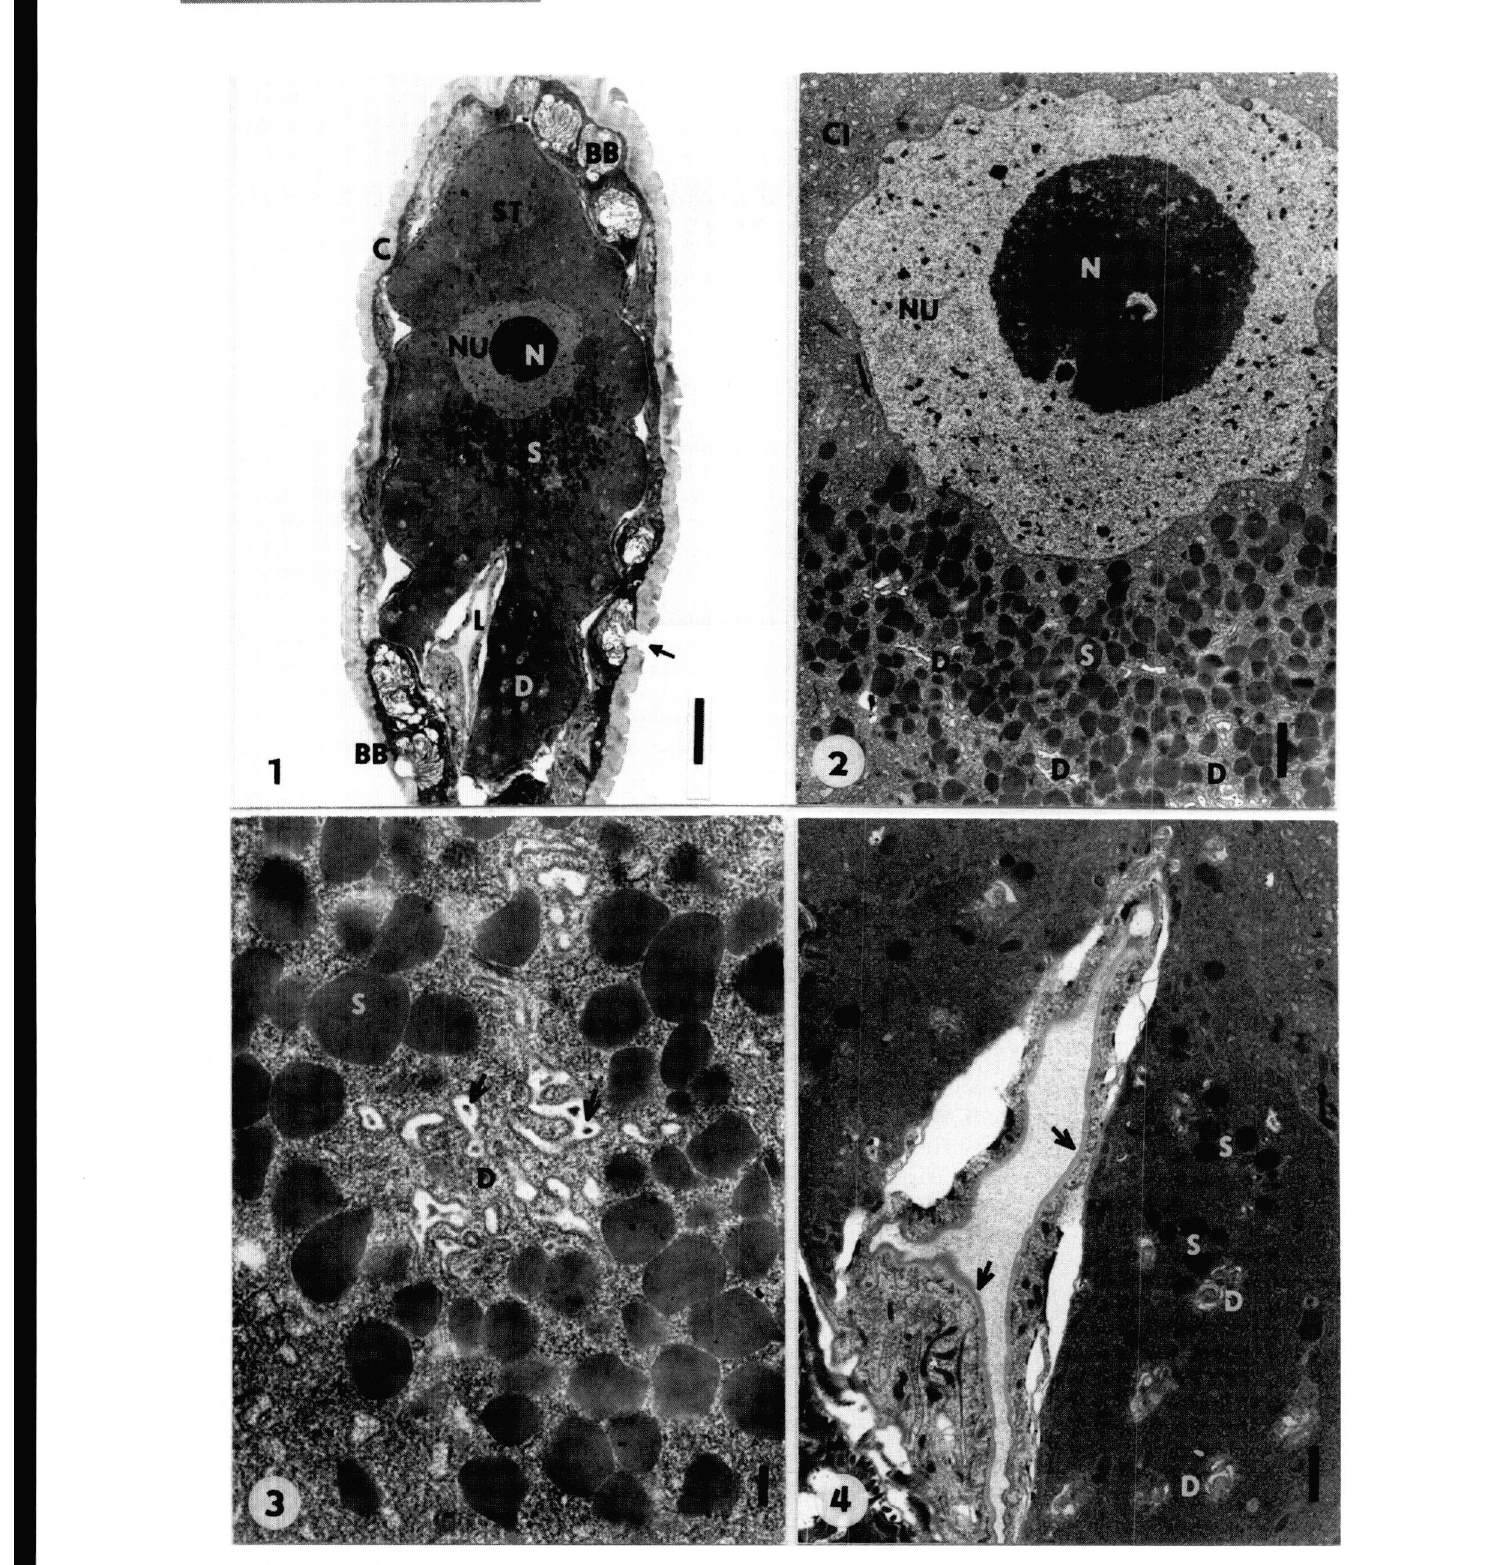
Figs 1 -4. - Stichocyte of C. pterophyili. Fig. 1. Oblique TEM section through the body of C. pterophylli in the region of the stichosome. The stichosome fills the entire pseudocoelom. The stichocyte (ST) surrounds the lumen (L) of the esophagus. NU: nucleus, N: nucleolus, S: dense secretory granules, D: collecting ducts, BB: bacillary band gland cells, arrow: pore of BB, C: cuticle, scale bar = 5 µm. Fig. 2. Detail of Fig. 1. NU: nucleus, N: nucleolus, S: secretory granules, D: collecting ducts, CI: small cisternae of rough endoplamic reticulum, scale bar = 1 µm. Fig. 3. Detail of Fig. 2 (bottom right). Collecting ducts (D) contain electron dense secretory material (arrows). S: secretory gra nules, scale bar = 200 nm. Fig. 4. Lumen of the esophagus lined by a thin cuticle (arrows) connected with a thin epithelial layer. D: col lecting ducts, S: secretory granules, scale bar = 1